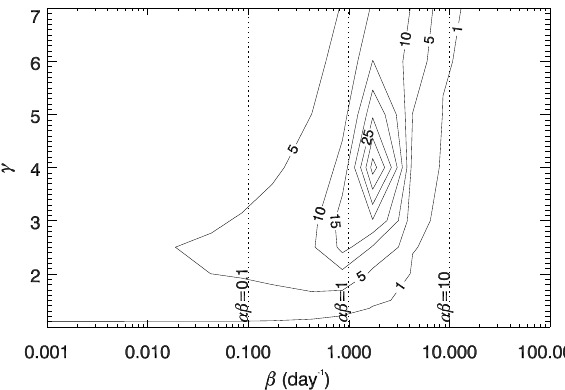
Figure 10. Correlation between the diurnal cycles of percentage of tracer in the coastal outflow layer in the MetUM simulation and box Fig. 10. Correlation between the diurnal cycles of percentage of model divided by the root mean square difference between the di- tracer in the coastal outflow layer in the MetUM simulation and urnal cycles. Tracer has 24h lifetime. The maximum indicates best parameter fit maximising box-model divided by the root mean square difference between the diurnal cycles. Tracer has 24-hour lifetime. The maximum indi- cates best parameter fit maximising correlation/bias.